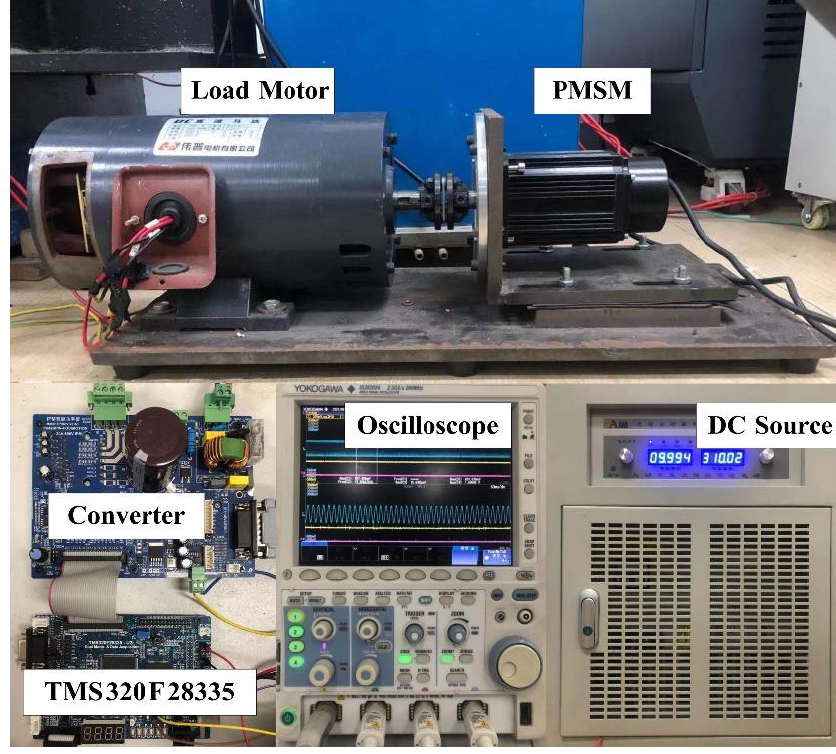
Figure 4. The experimental platform.